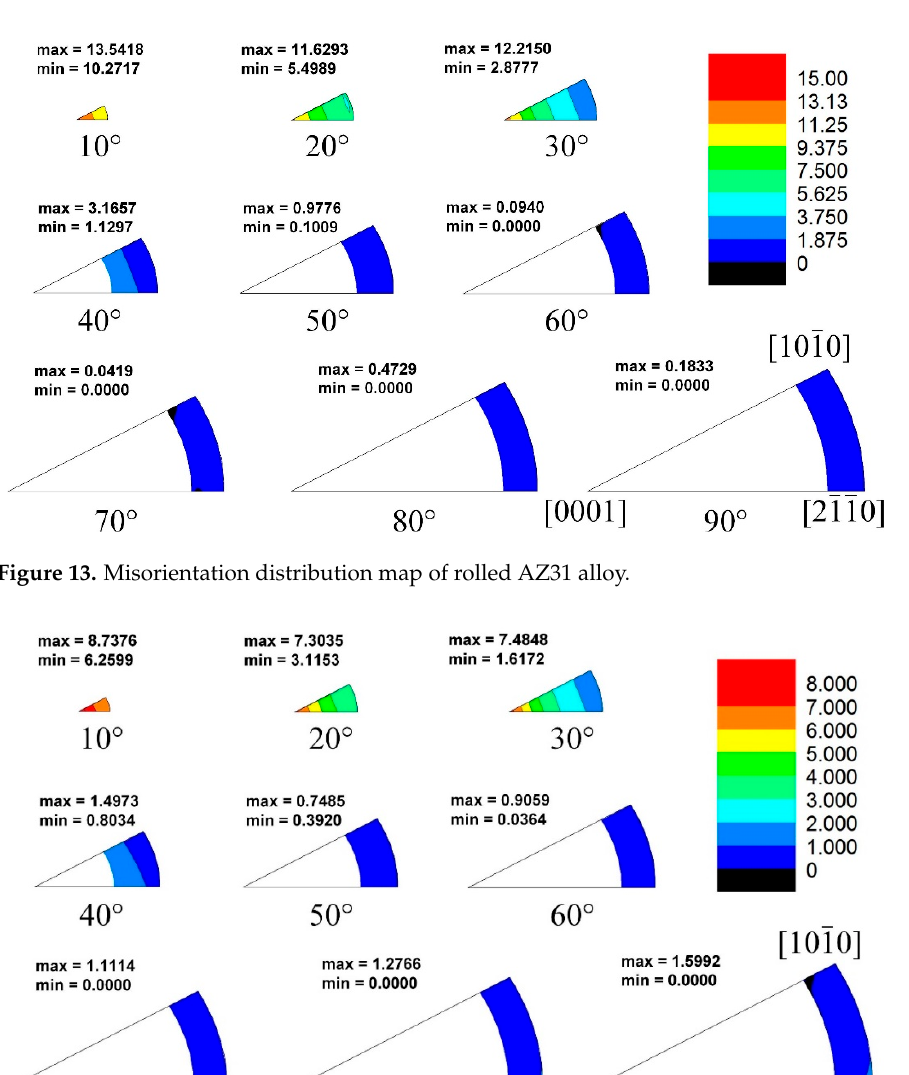
Figure 12. ( a ) Schmid factor distribution, and ( b ) elongation during tension tests of typical rolled AZ31 alloys and extruded alloys (data collected from the literature).